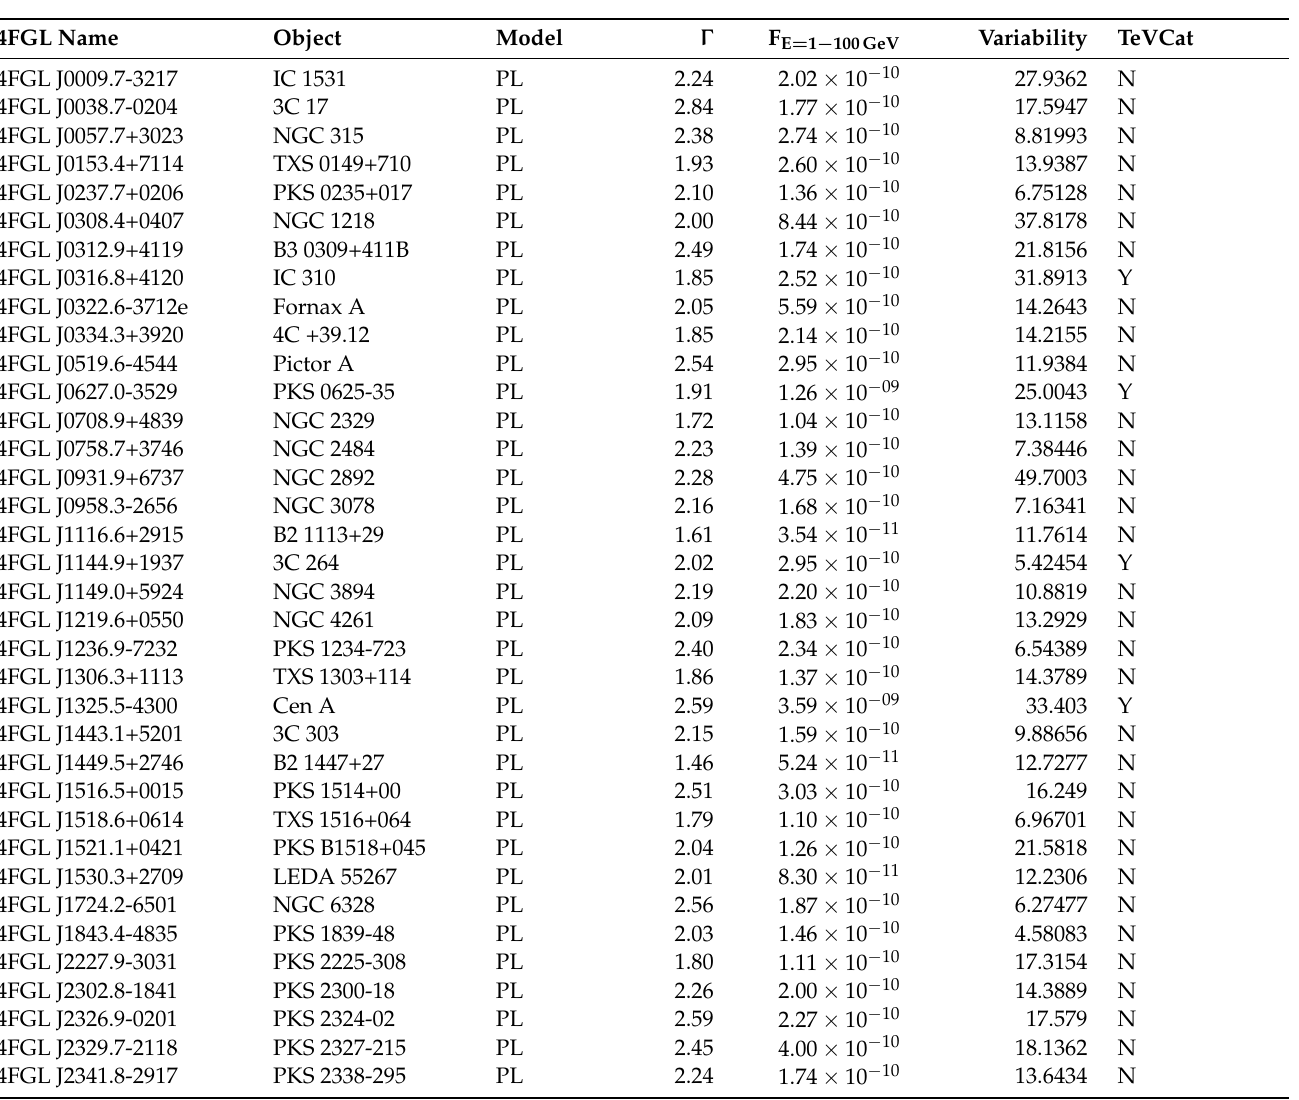
Table 1. The Fermi -LAT 4FGL-DR3 radio galaxies, sorted by right ascension, that exhibit SEDs best fitted with a power-law model. Although CenA is listed in this table, its SED is actually best fitted with a broken power-law model, as discussed in this review and elsewhere, e.g., [46,47]. The columns include the 4FGL catalogue name, an alternative object name, the type of model best fitted to the SED where PL is for power-law, the spectral index value ( Γ ), the photon flux